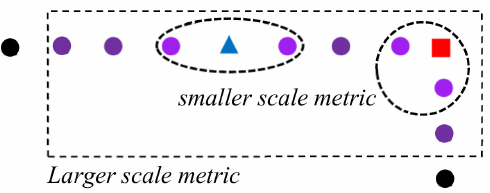
Figure 3. The blue triangle is an edge point, and the red square is a corner point. When classified at a large scale, the edge point is likely to be classified into corners.